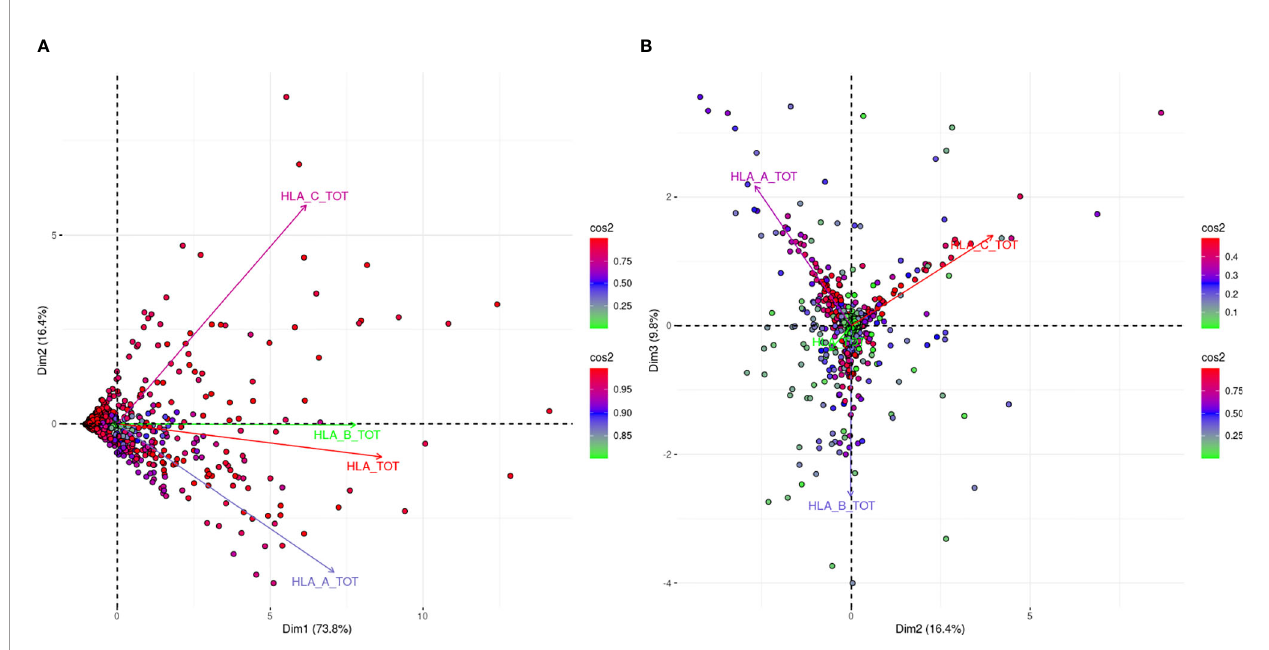
FIGURE 1 | PCA biplot projections of locus speci fi c and total (HLA-A, -B, -C loci) summed MFI values. Panel (A) (left part) Projects variables and individuals on the fi rst PCA-de fi ned plane, while Panel (B) (right part) represents the second PCA plane. The points represent projections of individual reactions and arrows of the different anti-HLA class I responses. The color vectors on the right side of both panels represent the cos2 value of the explained variance for variables and individuals